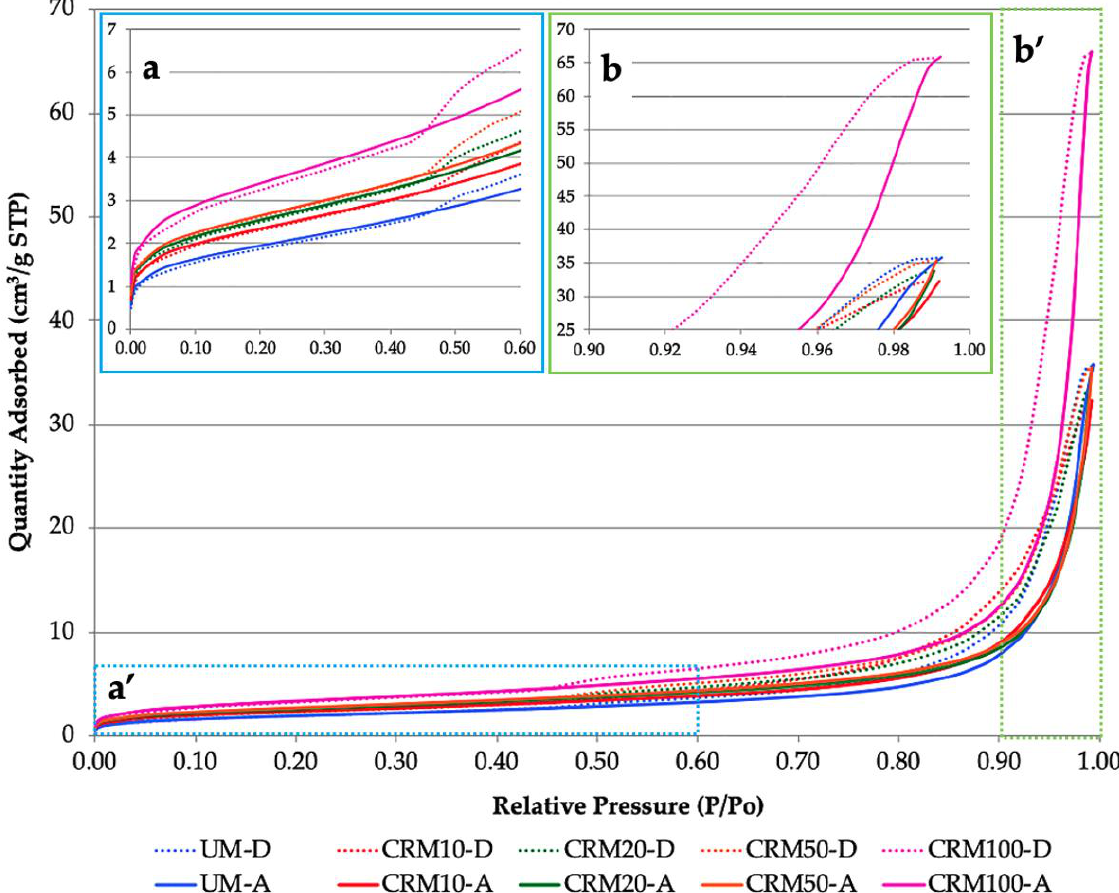
Figure 5. Adsorption-desorption isotherms of CRMs: ( a ) the beginning of the adsorption-desorption isotherm curves is shown; specifically, the amount of molecules adsorbed and desorbed at low pressures (blue box a’); ( b ) the final part of the isotherm curves is shown; specifically, the amount of adsorbed and desorbed molecules at high pressures (green box b’).